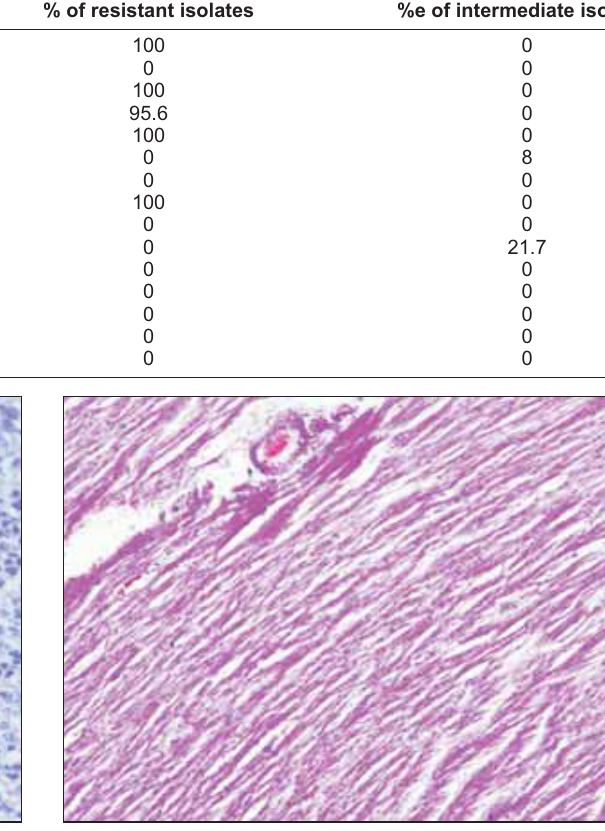
Figure-3: Microphotograph showing fibrinous exudate and flooding of polymorphonuclear cells in alveoli.